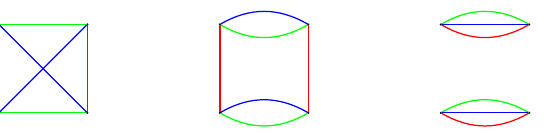
Figure 1 . Graphical representation of the quartic O ( N ) 3 invariants. From left to right: the tetrahedron, the pillow, and the double-trace (there are three pillow contractions, distinguished by the color of the vertical edge).